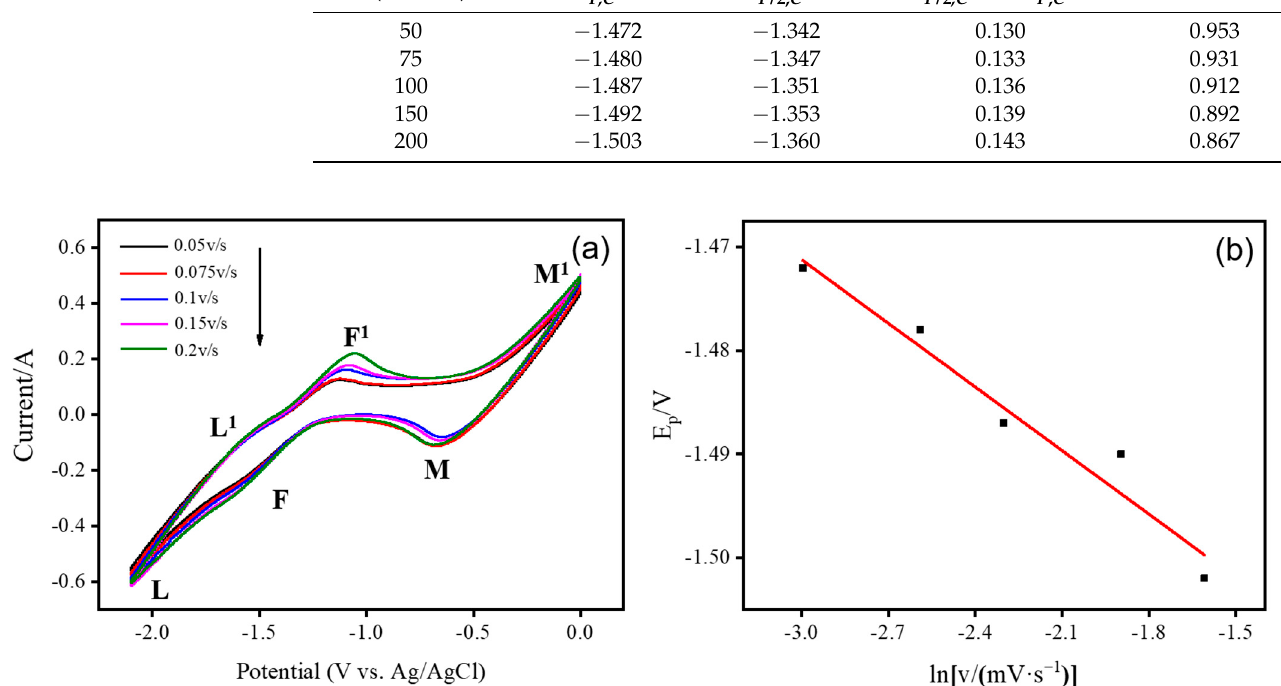
Figure 3. ( a ) Cyclic voltammetry of LiCl-KCl-CeCl 3 (3.0 wt.%) molten salt system at liquid metal indium electrode at 773 K at different sweep rates. Scan rate: 0.05–0.2 V-s − 1 , ( b ) Relationship between the peak cathode potential and the logarithm of the scan rate.